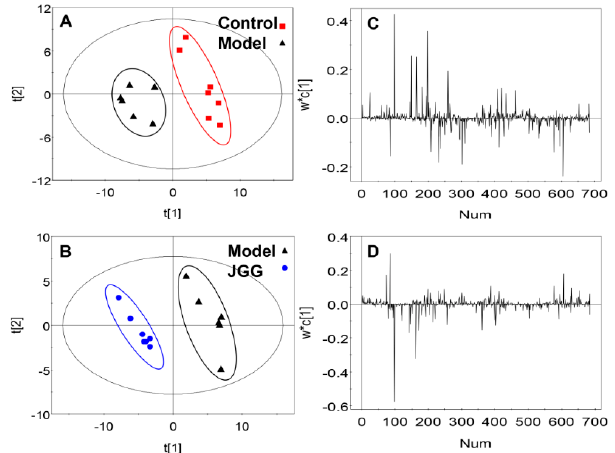
Figure 5. Score plot of the pairwise comparison between ( A ) the control vs. the CCl 4 model group. R2X (cum) = 0.494, R2Y (cum) = 0.928, Q2 (cum) = 0.725; ( B ) JGG vs. the CCl 4 model group. R2X(cum) = 0.463, R2Y (cum) = 0.974, Q2 (cum) = 0.827. Loading plot of the pairwise comparison between ( C ) the control vs. CCl 4 model group and ( D ) JGG vs. the CCl 4 model group. NUM is the abbreviation of Number. The ellipses are only for easier data visualization.